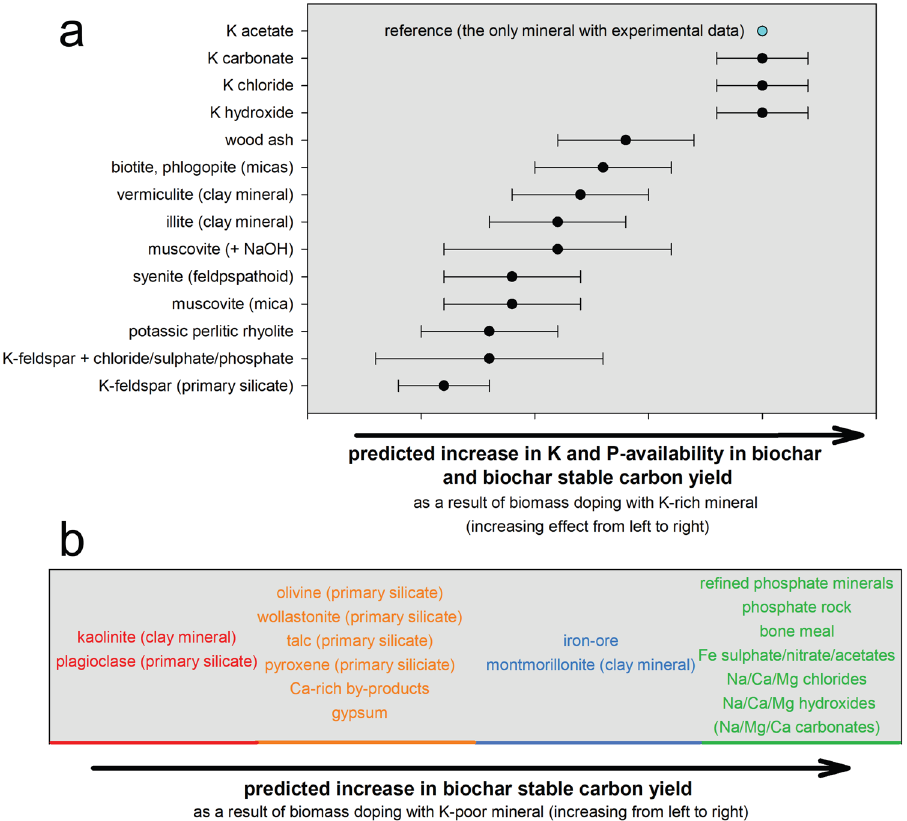
Fig. 3 Predicted increase in nutrient recovery and biochar stable carbon yield as result of biomass doping with minerals. a Effect of K-rich minerals on the K-availability and P-availability in the resulting biochar and b effect of K-poor minerals on the biochar stable carbon yield. Only in a few cases experimental data exist and hence the effects are predicted effects based on the availability/mobility of a K and b phosphates/Na/Ca/Mg/Fe in the respective minerals (assessment details reported in Supplementary Tables 2 and 3). In a the uncertainty of the effect is highlighted by error bars. Predicting the effect of several components (phosphates/Na/Ca/Mg/Fe) as done in b has a much higher uncertainty, therefore, no error bars are reported. In b Na/ Mg/Ca carbonates are set in brackets because carbonates increase the stable carbon yield but the overall effect on the carbon sequestration potential of biochar is uncertain due to CO 2 release from carbonate